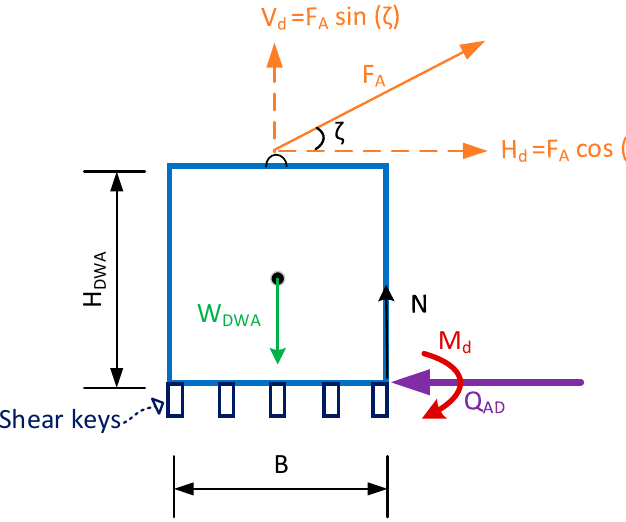
Figure 5. Free ‐ body diagram of a deadweight anchor. Figure 5. Free-body diagram of a deadweight